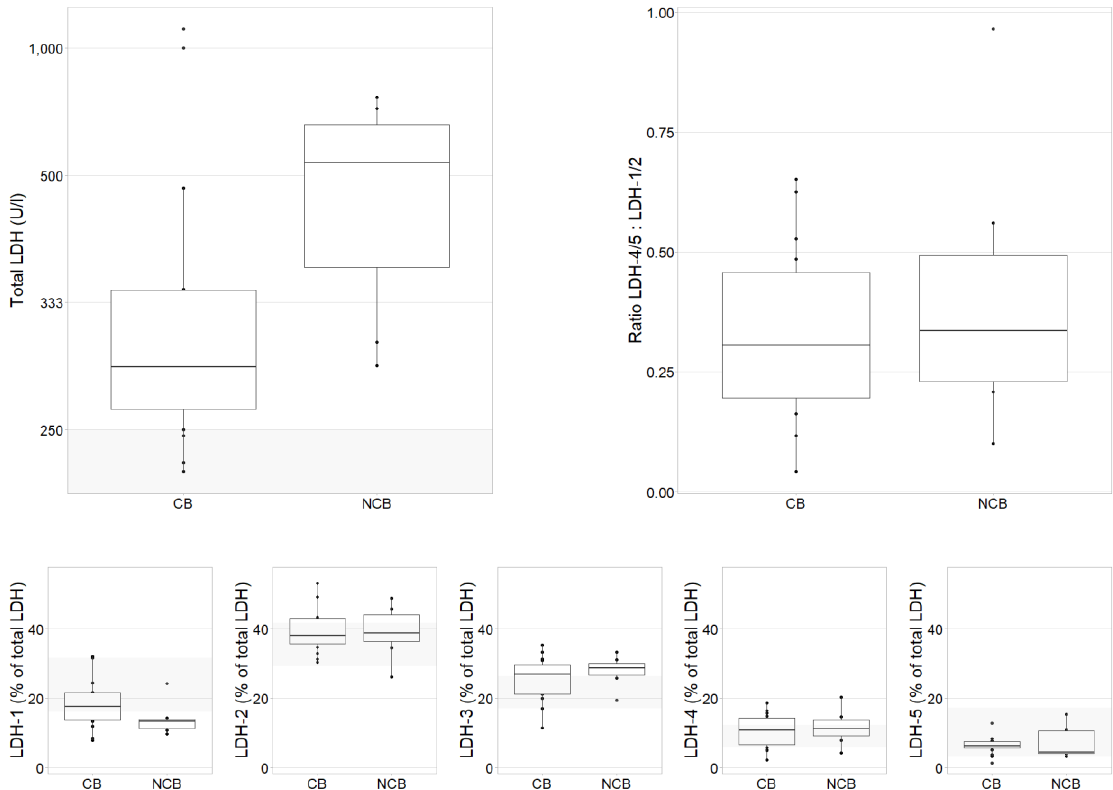
Figure 4. Differences between patients with versus without clinical benefit to immune checkpoint inhibitors. The large plots in the upper part of the figure depict the difference in total LDH levels and the ratio between LDH-4/5 and LDH-1/2. The differences in individual isotypes are shown below. Grey areas indicate the normal range. Abbreviations: CB = Clinical benefit; NCB = No clinical benefit.